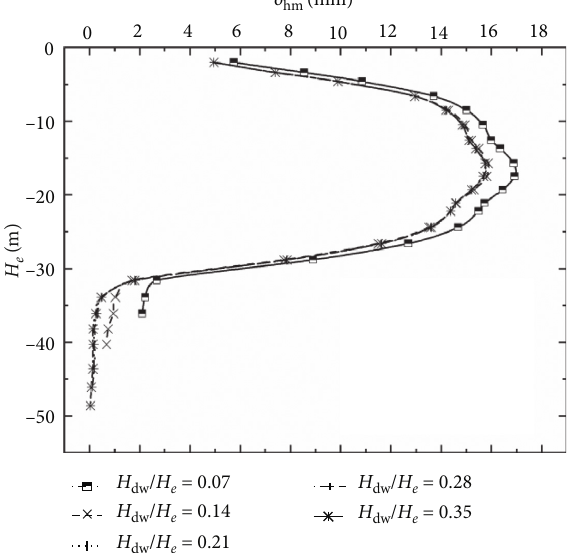
Figure 16: Deflection of diaphragm wall under different insertion ratio.